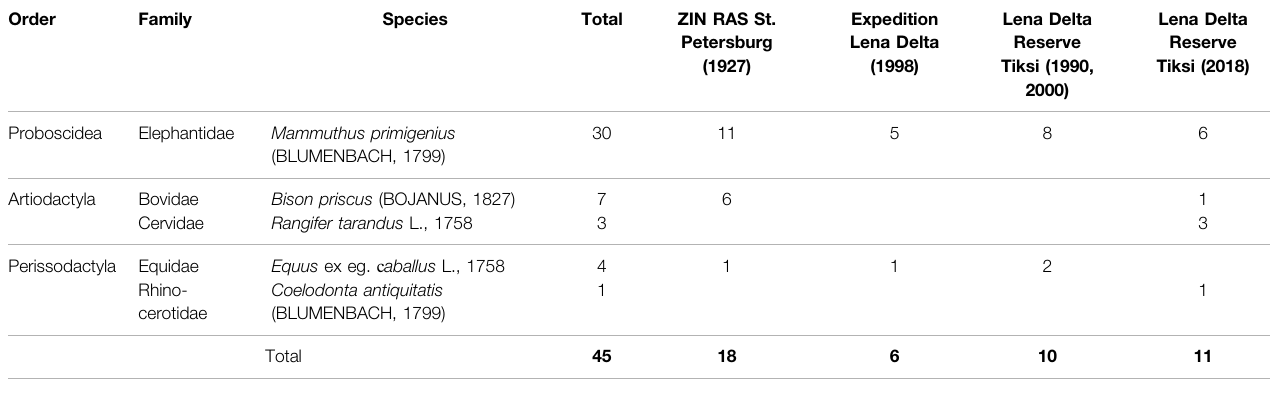
TABLE 1 | List of bone fi ndings of the late Pleistocene Mammoth fauna on Sobo-Sise Island in the eastern Lena Delta. Order